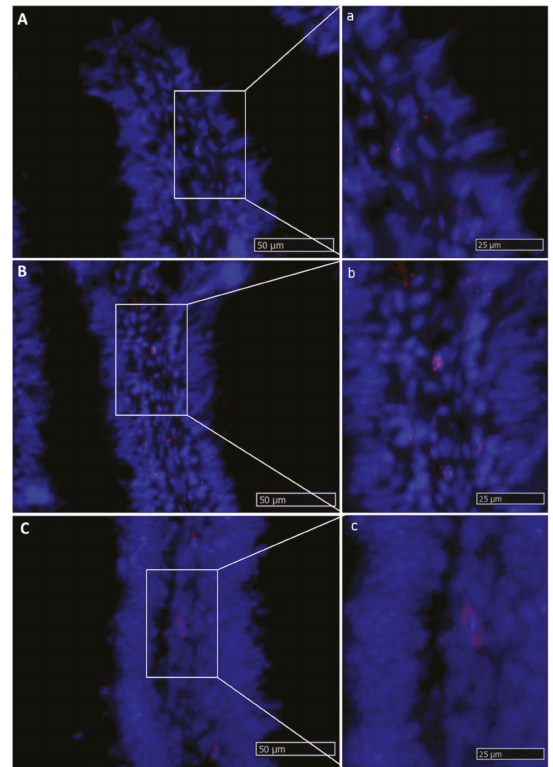
Figure 13. In situ hybridization of notch1 mRNA expression in di ff erent segments of the rainbow trout mid-intestine. The lowest expression was seen in the first segment of the mid-intestine ( A , a ): higher magnification), and an intermediate signal was observed in the pyloric caeca ( B , b ): higher magnification), whereas the basal part of the complex folds and the rest of the second segment of the mid-intestine displayed the highest signal ( C , c ): higher magnification).